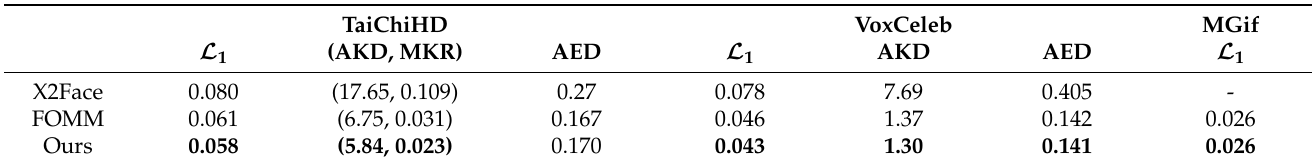
Table 1. Comparing the video reconstruction evaluation indicators. FOMM and FOMM-CBAM (ours) set the number of key points to 10 (the best result is displayed in